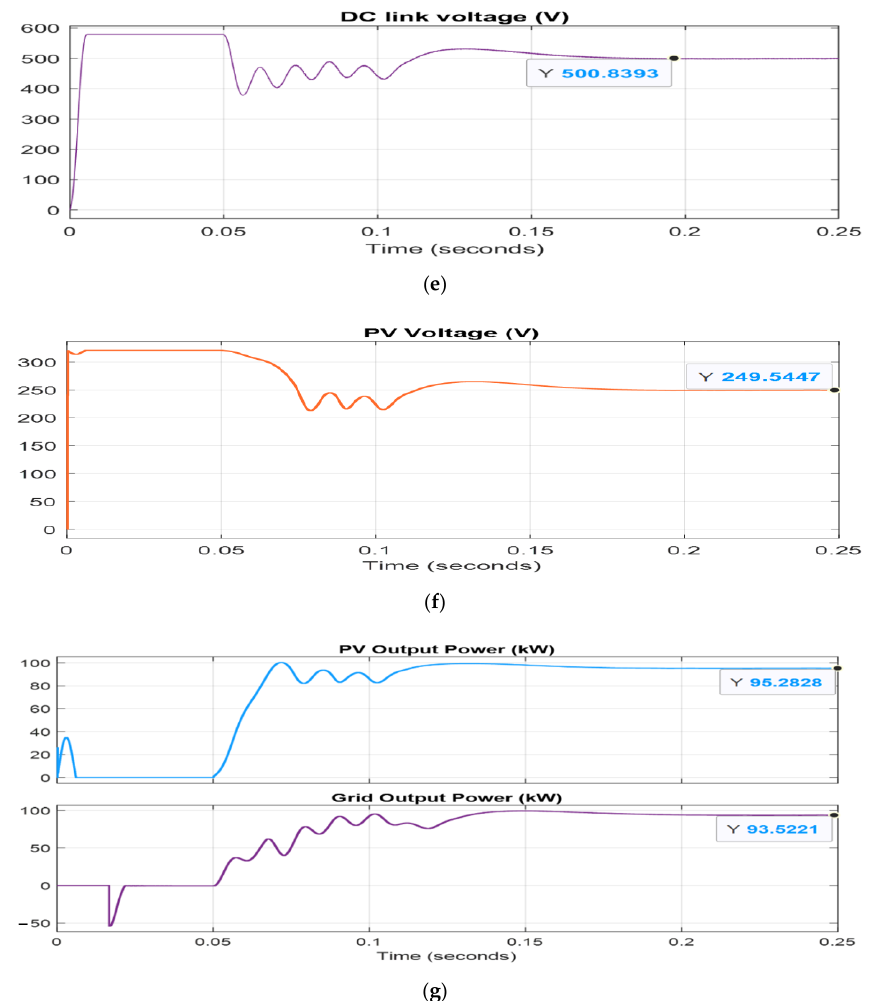
Figure 8. ( a ) Converters block/de-block; ( b ) DC link and reference voltage; ( c ) solar PV voltage corresponding to open circuit voltage; ( d ) boost converter duty cycle; ( e ) regulated DC link voltage; ( f ) solar output voltage and power; ( g ) solar PV and grid output power. At t = 0.4 to 0.6 s, PPP tracking is enabled while the PPP regulator initiates the regu- lation processing by controlling and varying the duty cycle to extract the peak power.